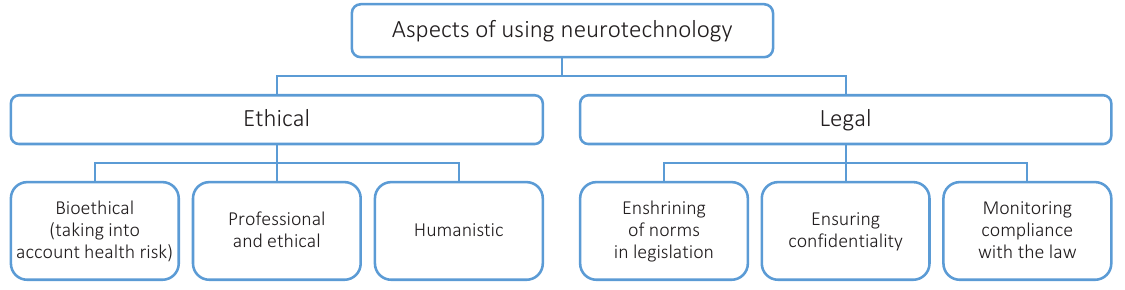
Figure 1. Ethical and legal aspects of using